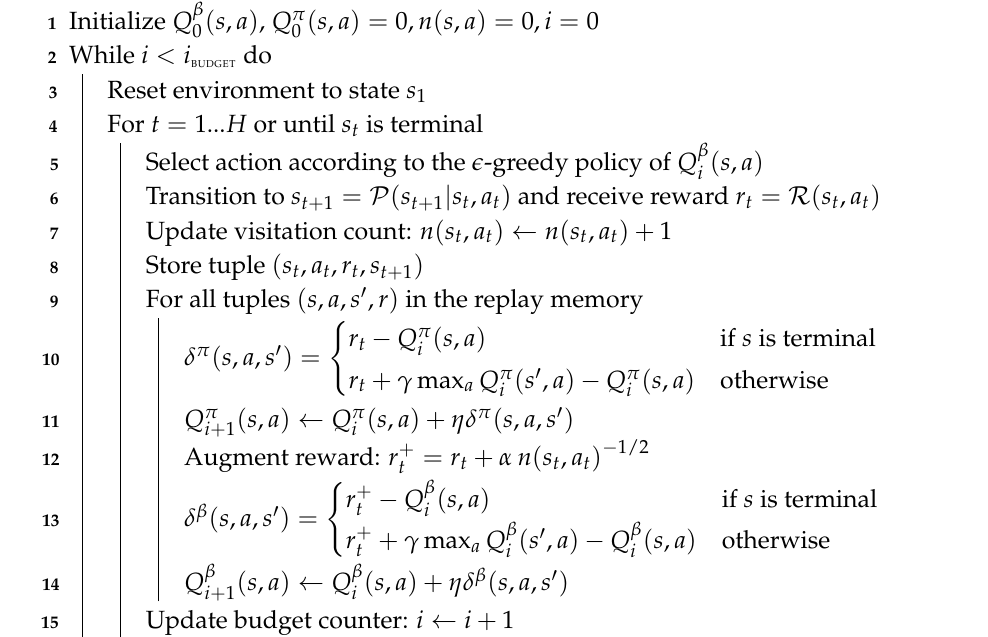
Algorithm A2: Tabular Q-Learning with Replay Memory and Augmented Reward